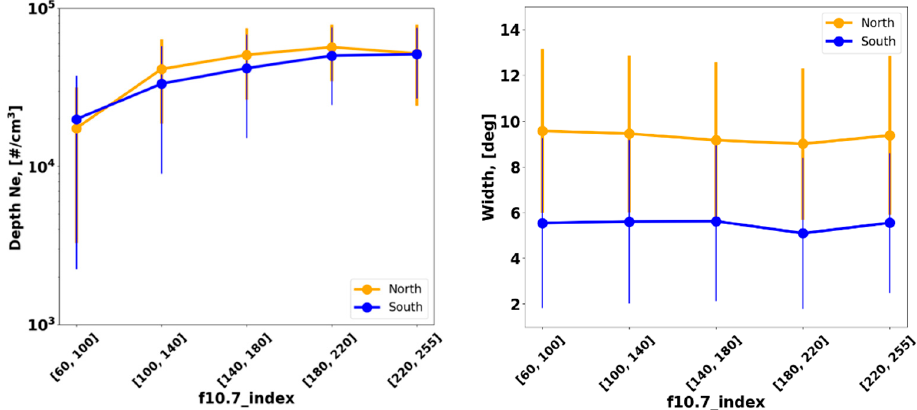
Figure 8. Variation in depth and width of the mid-latitude trough due to the F10.7 index in the northern and southern hemispheres.